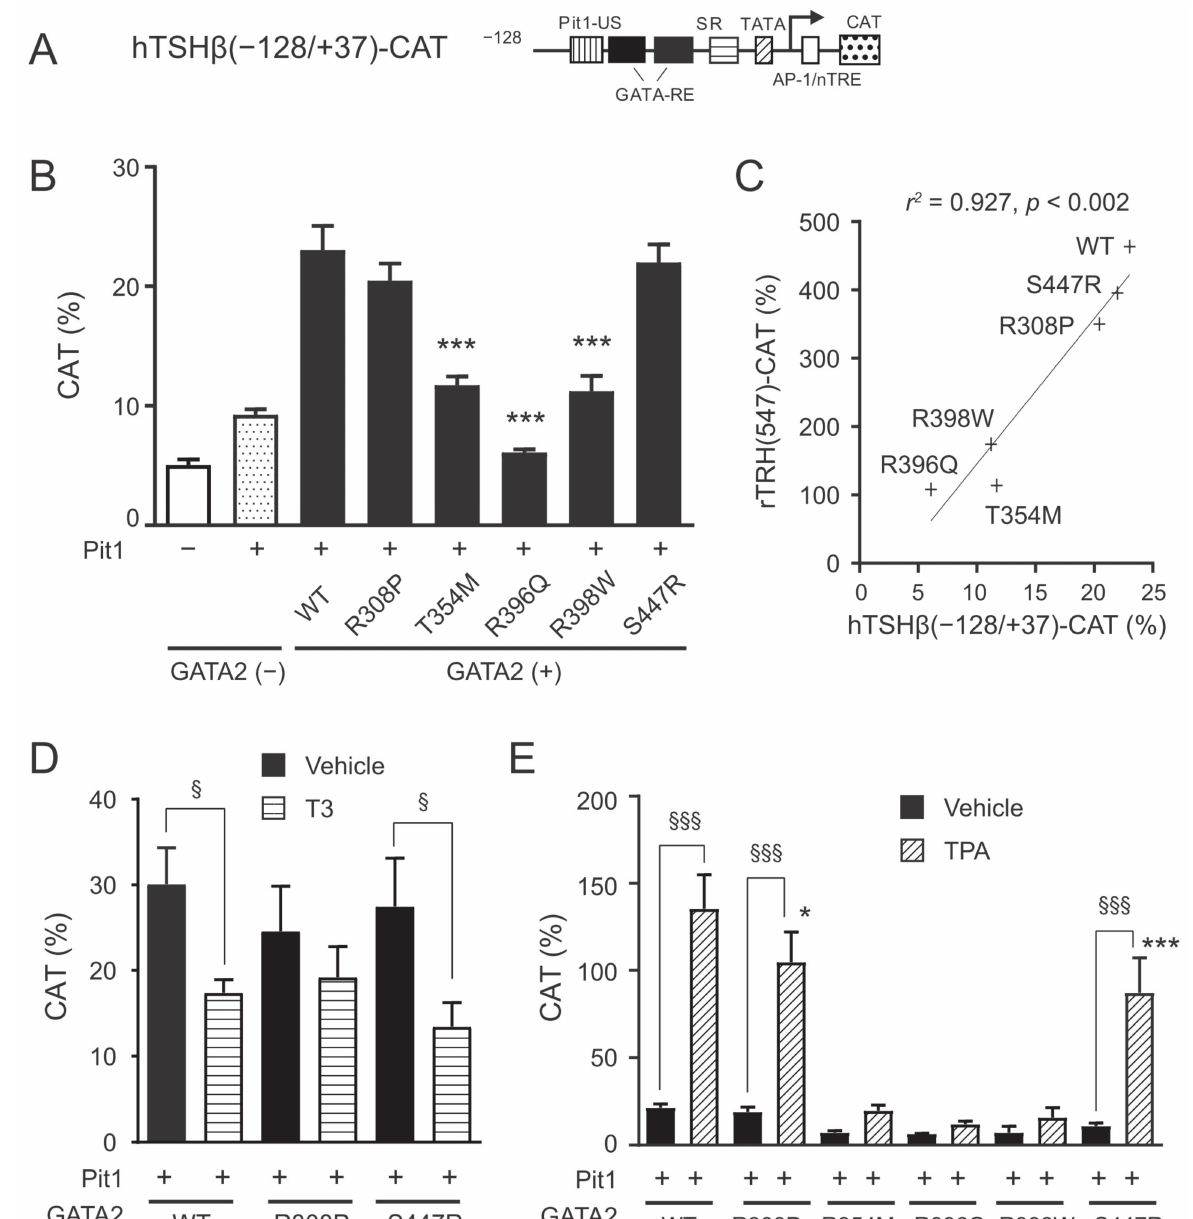
Figure 3. GATA2 mutations impair basal TSH β transcriptional activity and positive regulation by protein kinase C (PKC) pathway. ( A ) Schematic representation of hTSH β ( − 128/+37)-CAT. GATA-RE, GATA responsive element; Pit1-US, Pit1- binding site upstream of GATA-REs; SR, suppressor region; AP-1, AP-1-binding site; nTRE, negative T 3 responsive element; CAT, chloramphenicol acetyltransferase. ( B ) hTSH β ( − 128/+37)-CAT (1.0 µ g) was transfected into CV1 cells along with expression plasmids for various GATA2 mutants (0.2 µ g), Pit1 (0.1 µ g), TR β 2 (0.2 µ g), and pCMV- β -galactosidase (0.2 µ g). ( C ) Scattergram showing the relationship of hTSH β ( − 128/+37)-CAT activity against rTRH(547)-CAT. The solid line is the regression line. ( D ) Transient transfection was conducted as described in ( B ). After 24 h of culture, the cells were treated with vehicle or 10 nM T 3 for an additional 24 h. ( E ) hTSH β ( − 128/+37)-CAT (1.0 µ g) was transfected into CV1 cells along with expression plasmids for various GATA2 mutants (0.2 µ g), Pit1 (0.1 µ g), TR β 2 (0.2 µ g), and pCH111- β -galactosidase (0.5 µ g). After 24 h of culture, the cells were treated with 10 nM of the PKC activator tetradecanoylphorbol acetate (TPA) for an additional 24 h. CAT activity was normalized with β -galactosidase activity. CAT activity for pCMV-CAT (5 ng/well) was taken as 100%. Data are expressed as the mean ± S.E. of at least three independent experiments. * p < 0.05; *** p < 0.001, compared with wild type (WT). § p < 0.05; §§§ p < 0.001, for the indicated